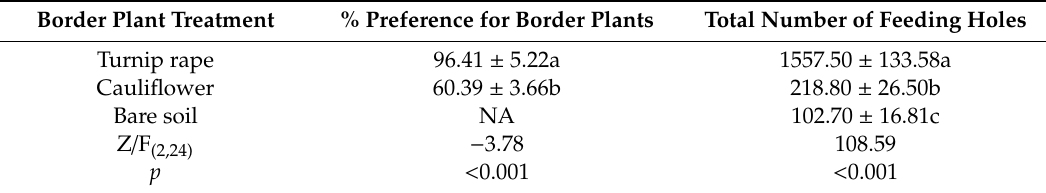
Table 2. Mean percentage feeding preference for border plants and total number of feeding holes on both border and ‘inner’ plants. Means are displayed with ± SEs. n = 10 for all means. Means with different letters (a–c) denote significant differences between treatments within a column.